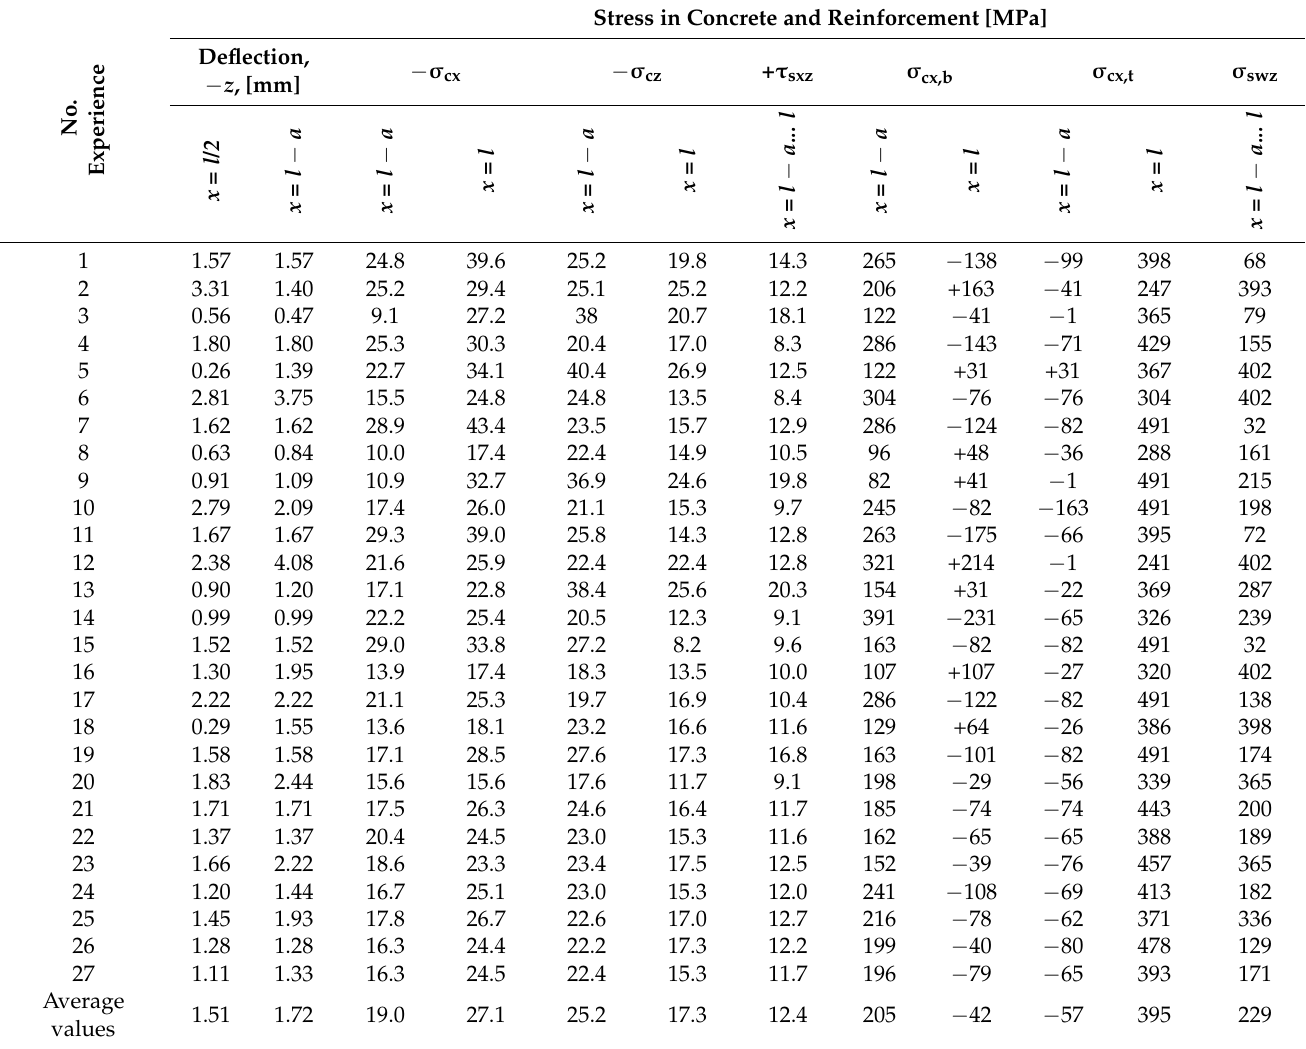
Table 2. The results of modeling the SSS of the supporting sections of continuous reinforced concrete beams (series V ) before the destruction ( F ∼ = 0.95 F u ) of their supporting sections, according to the bursting pattern above the middle support ( F/V ). Experience No. Deflection, − z , mm Stress in concrete and reinforcement,